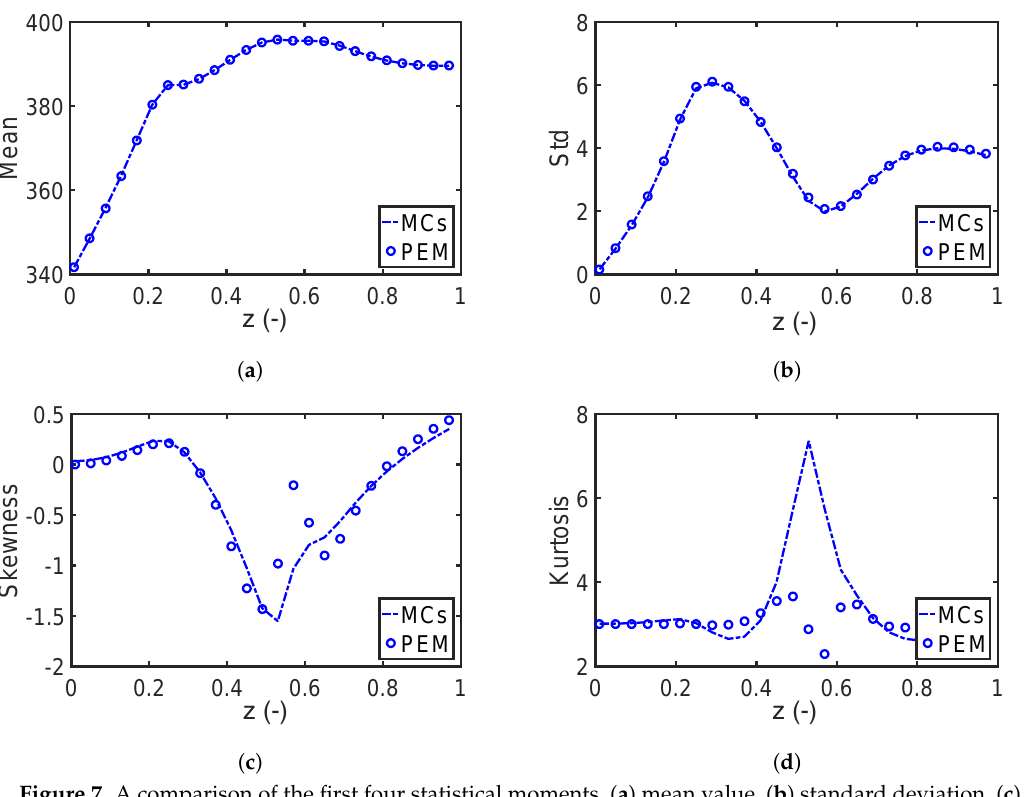
Figure 7. A comparison of the first four statistical moments, ( a ) mean value, ( b ) standard deviation, ( c ) skewness, and ( d ) kurtosis, estimated with the point estimate method (PEM) and Monte Carlo (MC) simulations for the reactor temperature in Case Study